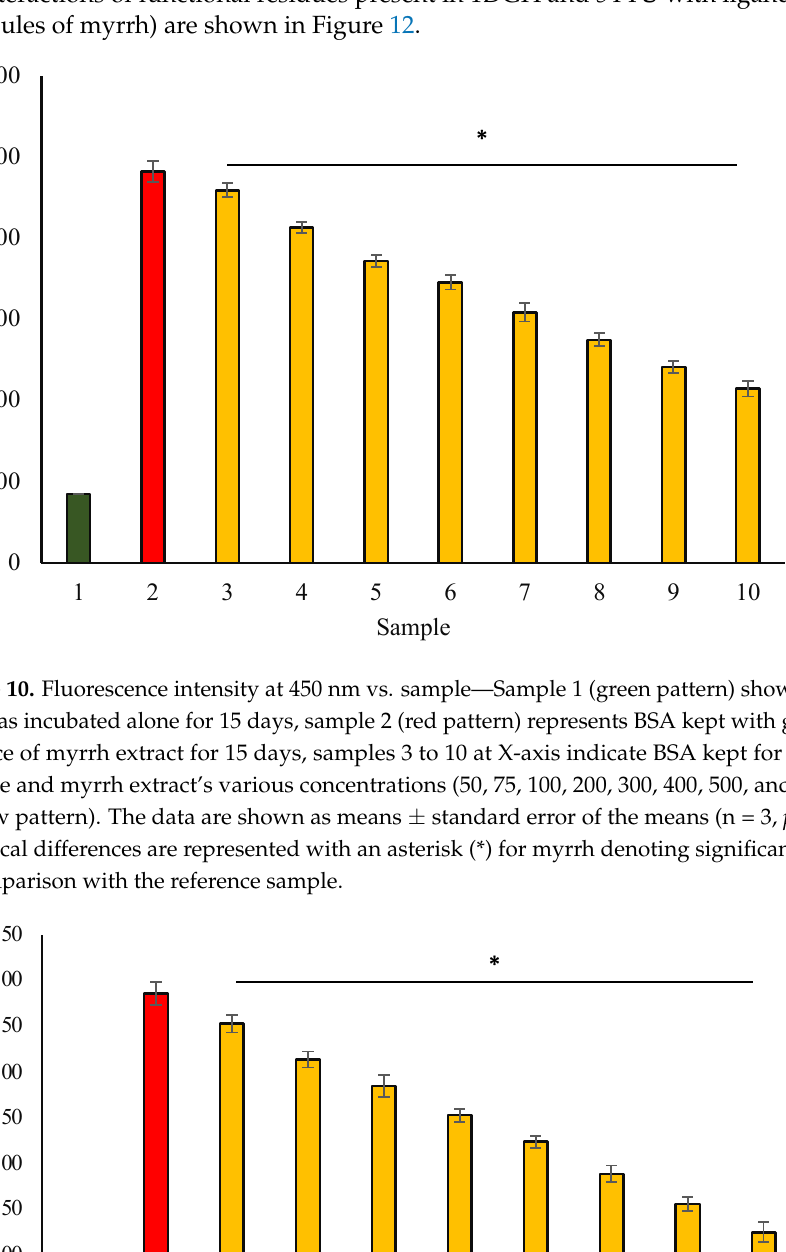
16 of 27 Figure 9. Absorbance at 280 nm vs. concentration (µg/mL)—Sample 1 (green pattern) shows native BSA that was incubated alone for 15 days, sample 2 (red pattern) represents BSA kept with glucose in the absence of myrrh extract for 15 days, samples 3 to 10 at X-axis indicate BSA kept for 15 days with glucose and myrrh extract’s various concentrations (50, 75, 100, 200, 300, 400, 500, and 600 µg/mL) (yellow pattern). The data are shown as means ± standard error of the means (n = 3, p < 0.05).